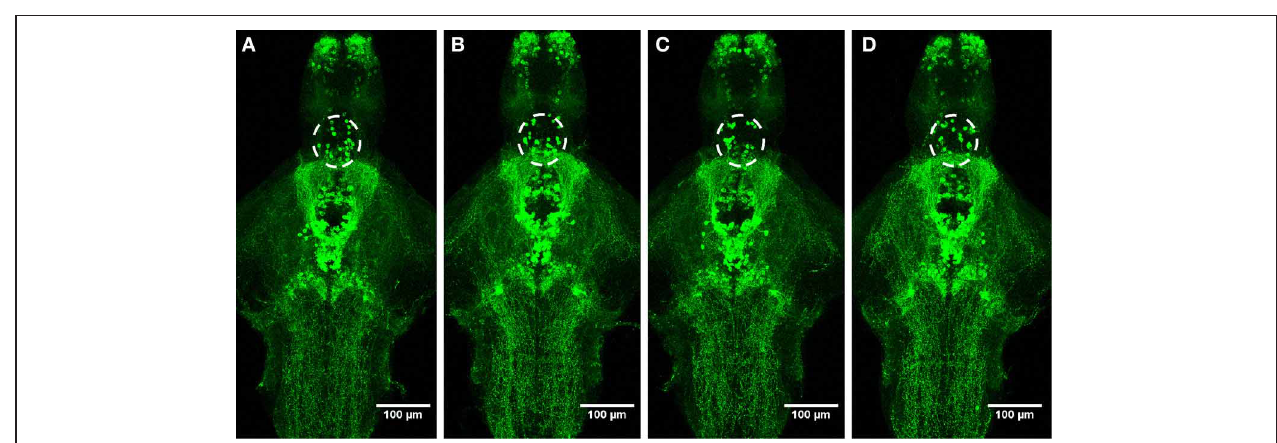
FIGURE 6 | Distribution of TH1-immunoreactive cells and fibers after a 30-min ethanol treatment. (A) Control, (B) 0.75% ethanol, (C) 1.50% ethanol, (D) 3.00% ethanol. No changes are seen between the groups. N = 8–10 larvae per treatment group.